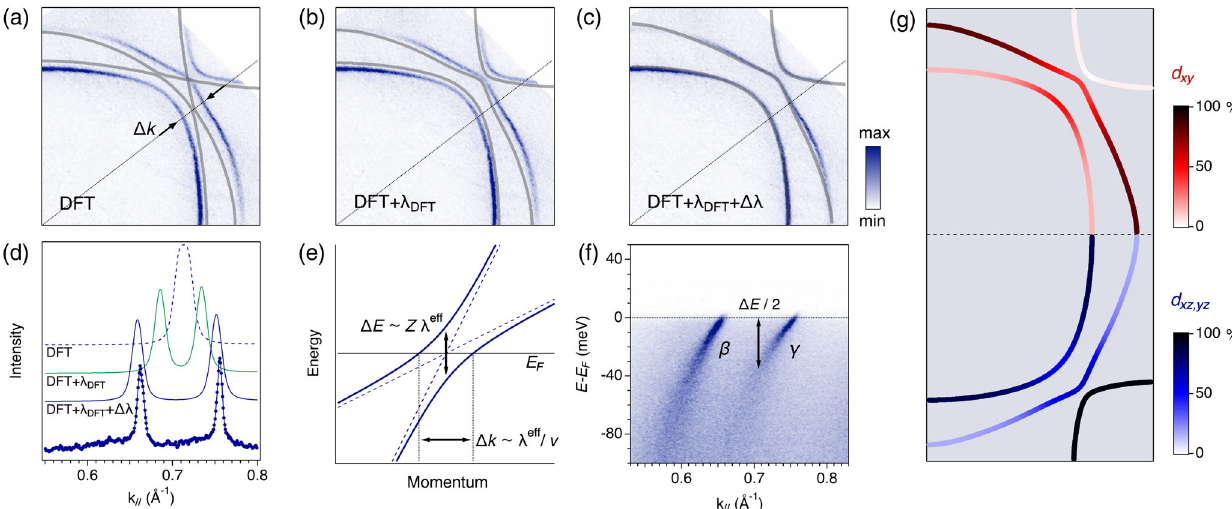
FIG. 3. Correlation enhanced effective SOC. (a) Quadrant of the experimental Fermi surface with a DFT calculation without SOC ˆ H DFT ≈ 0 . 4 π =c (grey lines). (b,c) Same as panel (a), with calculations including SOC (DFT þ λ ( ) at the experimental k z Δ λ ), respectively. For details, see the main text. (d) Comparison of the experimental MDC along the k -space enhanced SOC ( λ DFT þ cut indicated in panel (a) with different calculations shown in panels (a) – (c). (e) Schematic illustration of the renormalization of a ffiffiffiffiffiffiffiffiffiffiffi p Z ν Z ν 0 SOC-induced degeneracy lifting. Here, Z ¼ , where ν , ν 0 label the two bands, and v ¼ in the absence of SOC [23] (see text). (f) Experimental quasiparticle dispersion along the k -space cut indicated in panel (a). (g) Orbital Δ λ eigenstates along the Fermi character of the DFT þ λ DFT þ